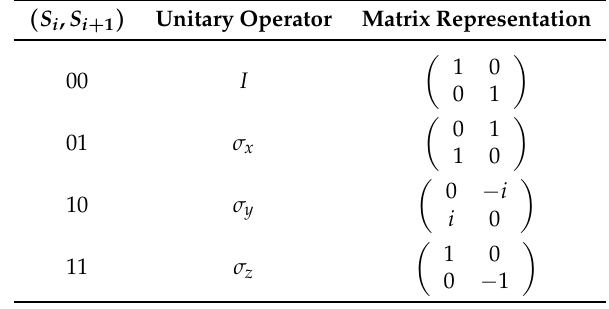
Table 2. The relationship of ( S i , S i + 1 ) in the sequence S and the corresponding unitary operation.